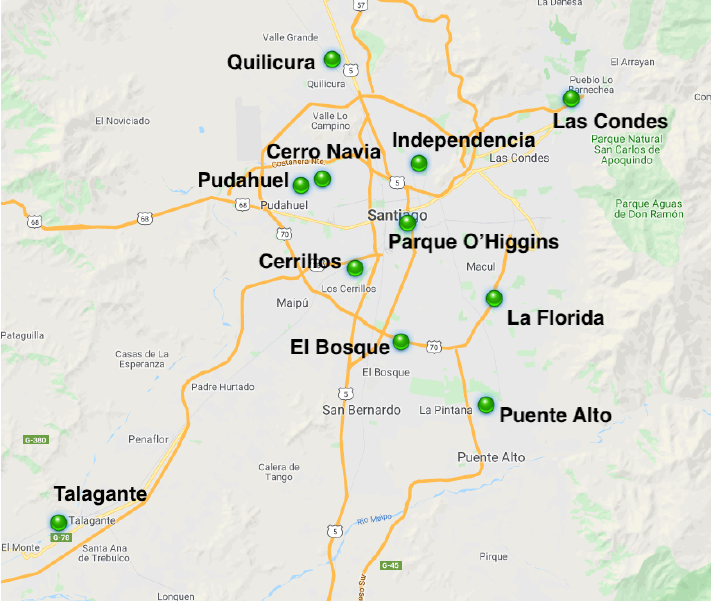
Figure 3. Google map of the the Metropolitan region (Chile) with the locations of the 11 meteorologi- cal